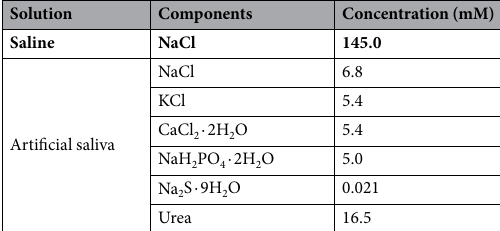
Table 1. Components of saline and artificial